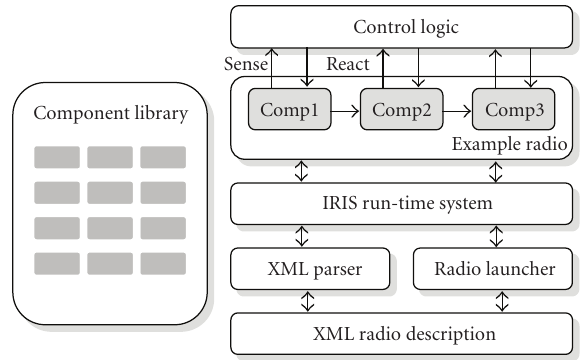
Figure 7: IRIS architecture.